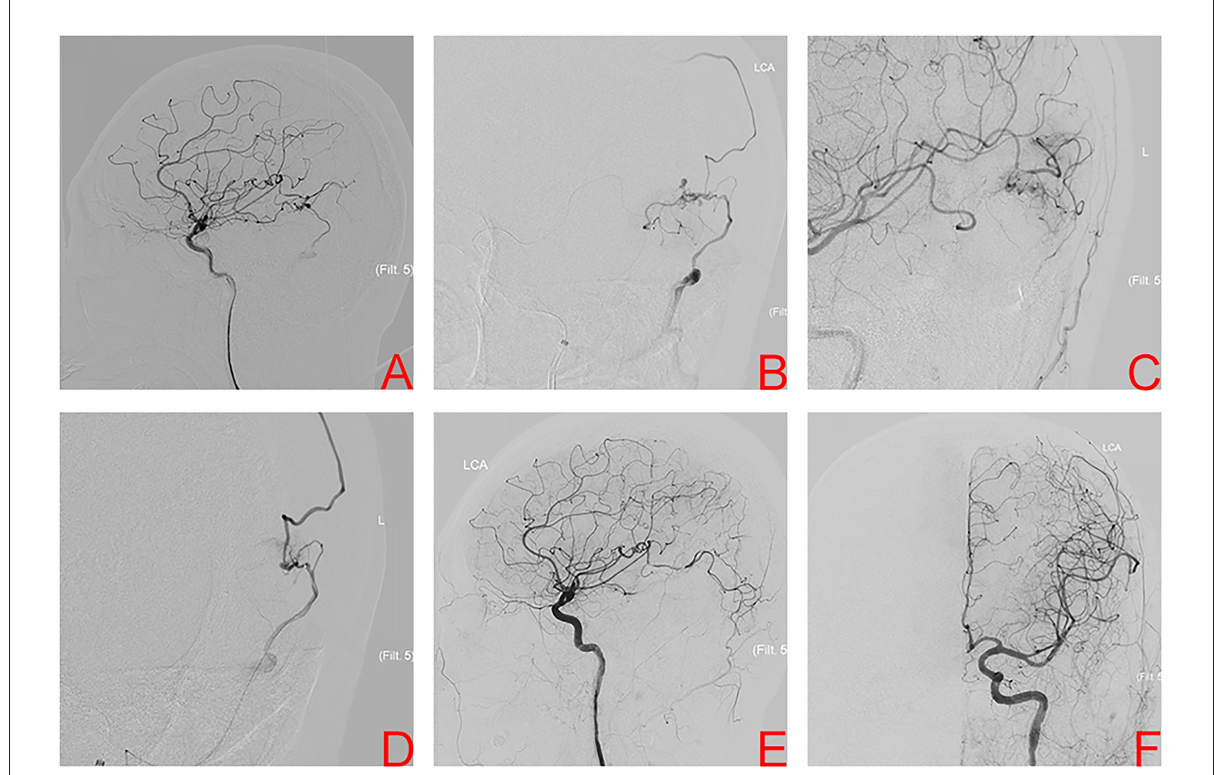
FIGURE4 Digital subtraction angiography of left internal carotid artery (ICA) after incomplete nidus resection and hematoma evacuation shows the left temporal arteriovenous malformation in case 4 (A) . Superselective arteriography and embolization via the temporal branches of the